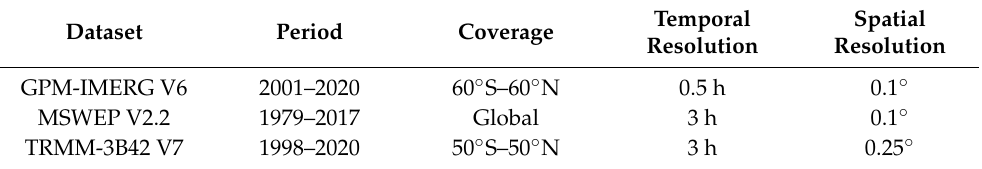
Table 1. Summary of characteristics for the three gridded precipitation datasets.